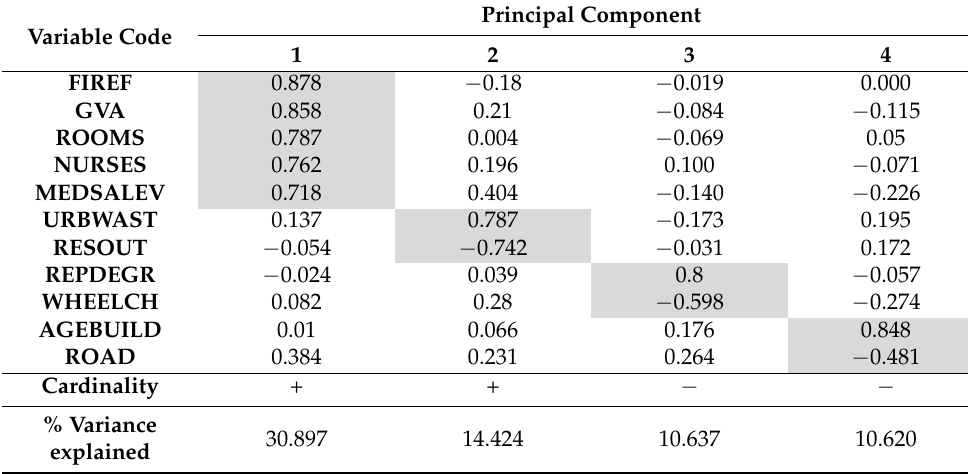
Table 5. Loadings, cardinality and percentage of variance explained for the 4 principal components extracted to express support capability. Loading values ≥ 0.4 or ≤− 0.4 are highlighted in grey. The total percentage of variance explained was